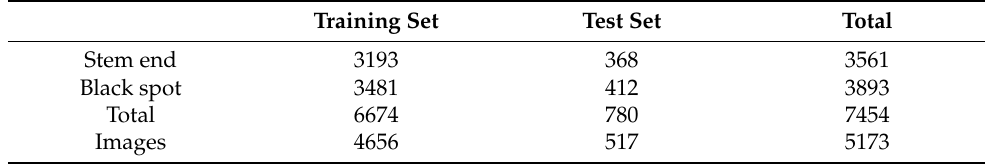
( a ) The green box annotates the stem end. ( b ) The red box annotates the black spot. Figure 4. The annotated detection objects. Table 1. Basic information on the pomelo dataset. Table 1. Basic information on the pomelo dataset.